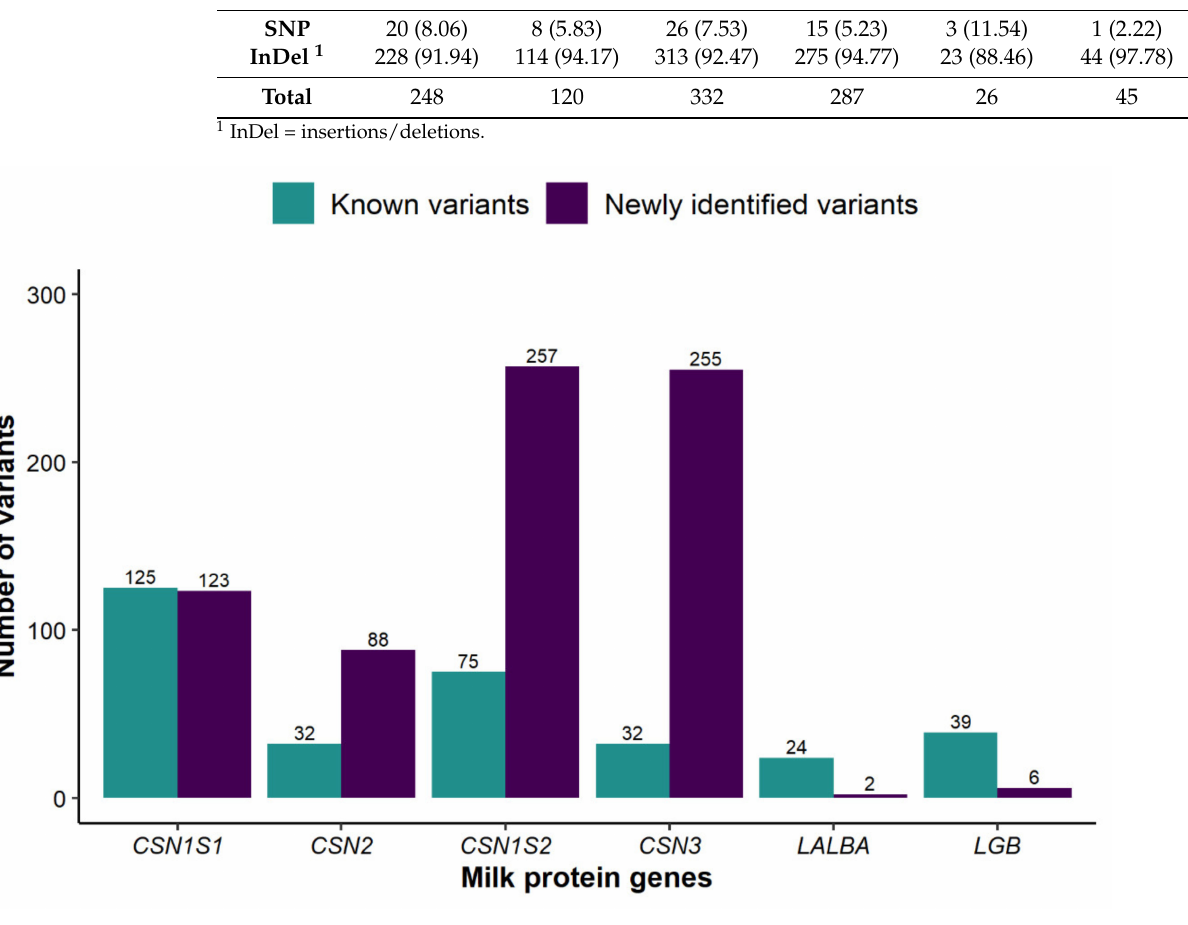
Figure 1. Distribution of known and novel DNA variants within the exon sequences, flanking intron sequences and parts of the 5 (cid:48) -upstream regions of milk protein genes ( CSN1S1 , CSN2 , CSN1S2 , CSN3 , LALBA , LGB ) in Beninese indigenous cattle